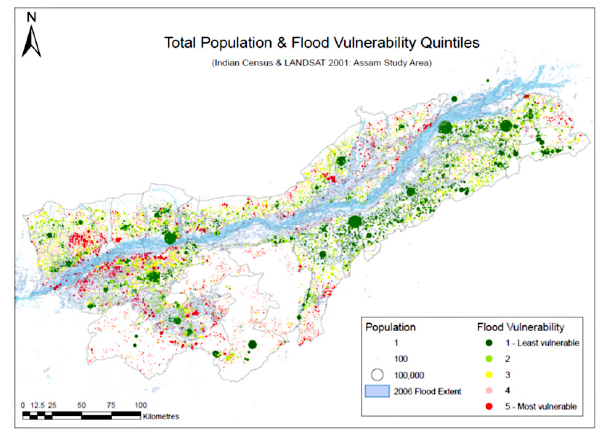
Figure 6. Vulnerability to flood based upon the geo-referenced In- dian census data (2001) and a weighted indicator approach. Flood extent of a large recent flood is used as a proxy for hazard. Mapped by settlement.